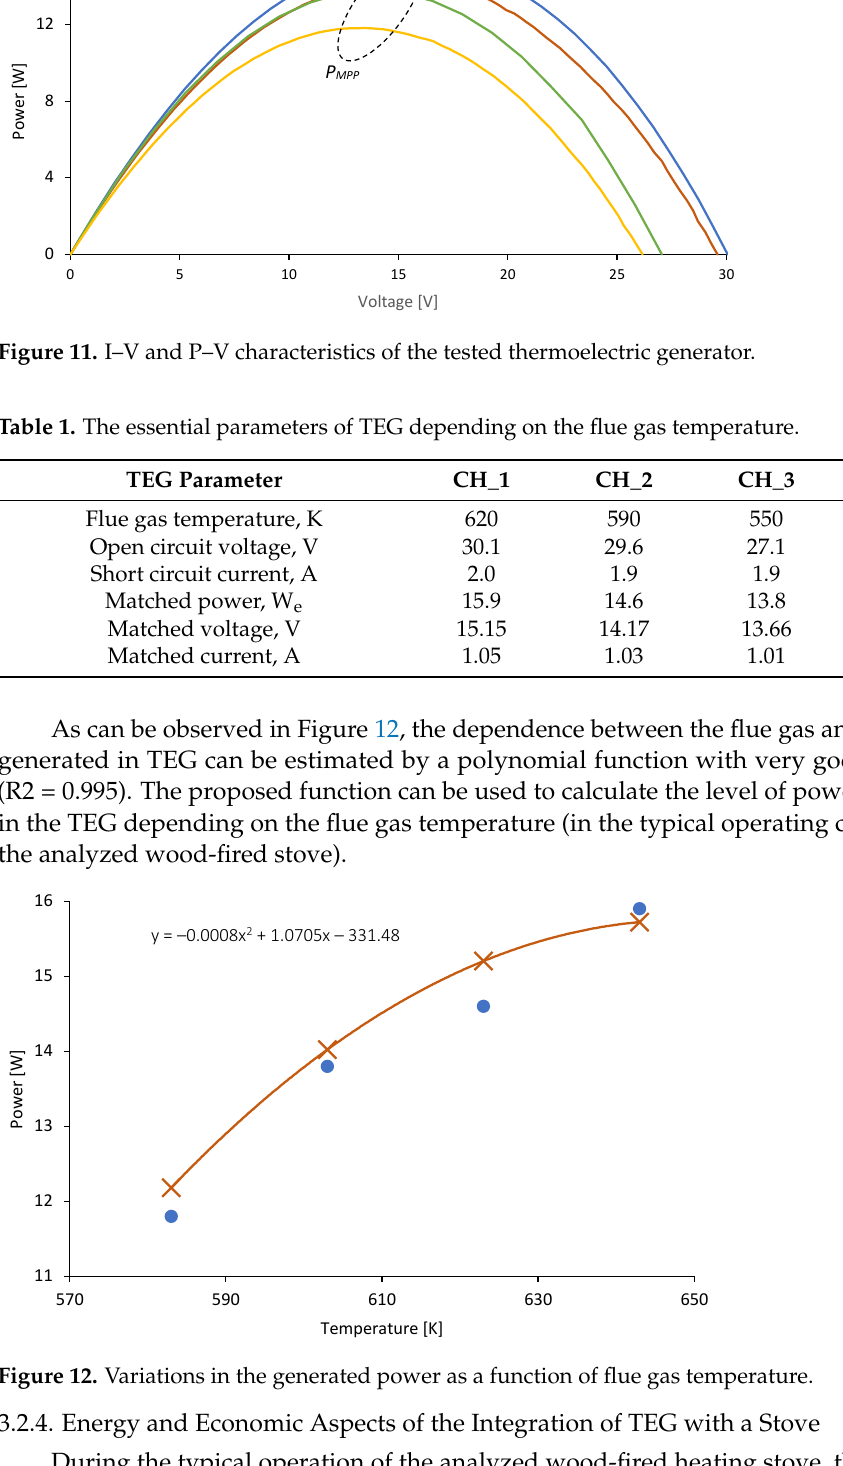
Figure 12. Variations in the generated power as a function of flue gas temperature.